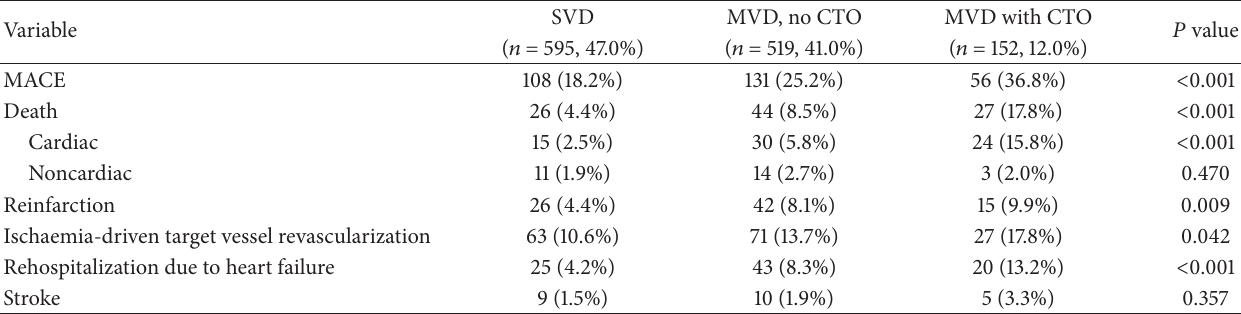
Table 3: Overall 3-year clinical outcomes of patients who underwent primary percutaneous coronary